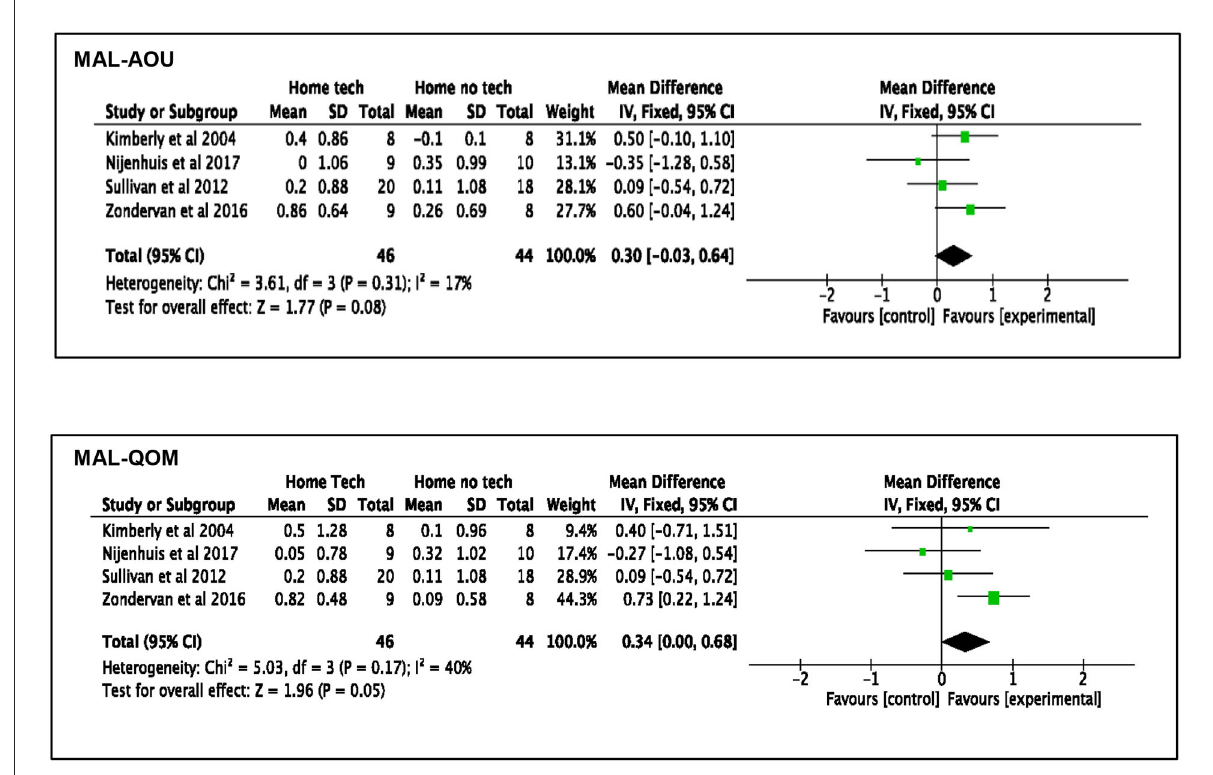
FIGURE5 Comparison of the effect of the technology-assisted home-based intervention and “no technology” intervention on MAL outcomes immediately after treatment MAL-AOU and MAL-QOM.